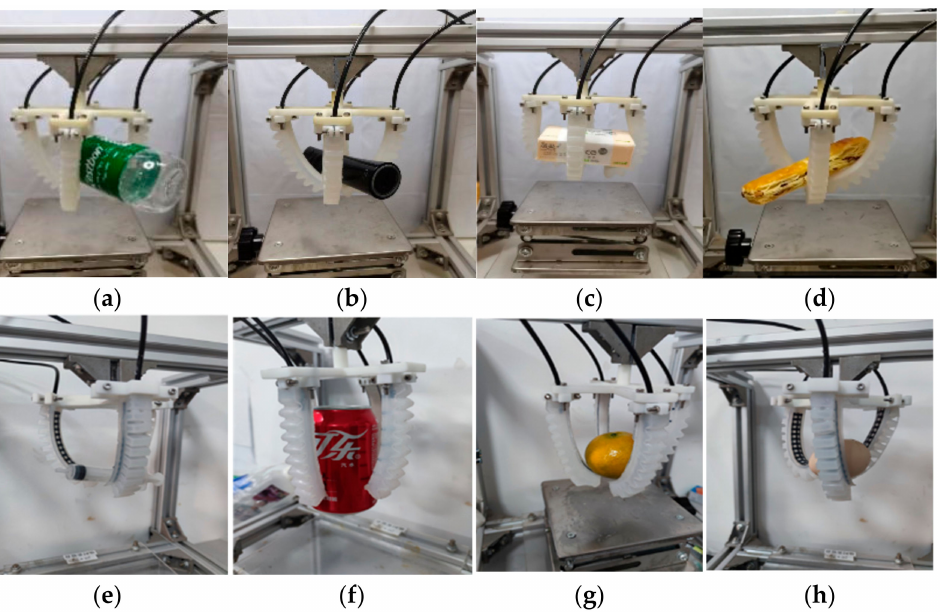
Figure 20. The schematic of soft gripper grasping different object ( a ) mineral water bottle; ( b ) remote controller; ( c ) napkin paper; ( d ) Bar bread; ( e ) needle tube; ( f ) cola-bottle; ( g ) oriange; ( h )